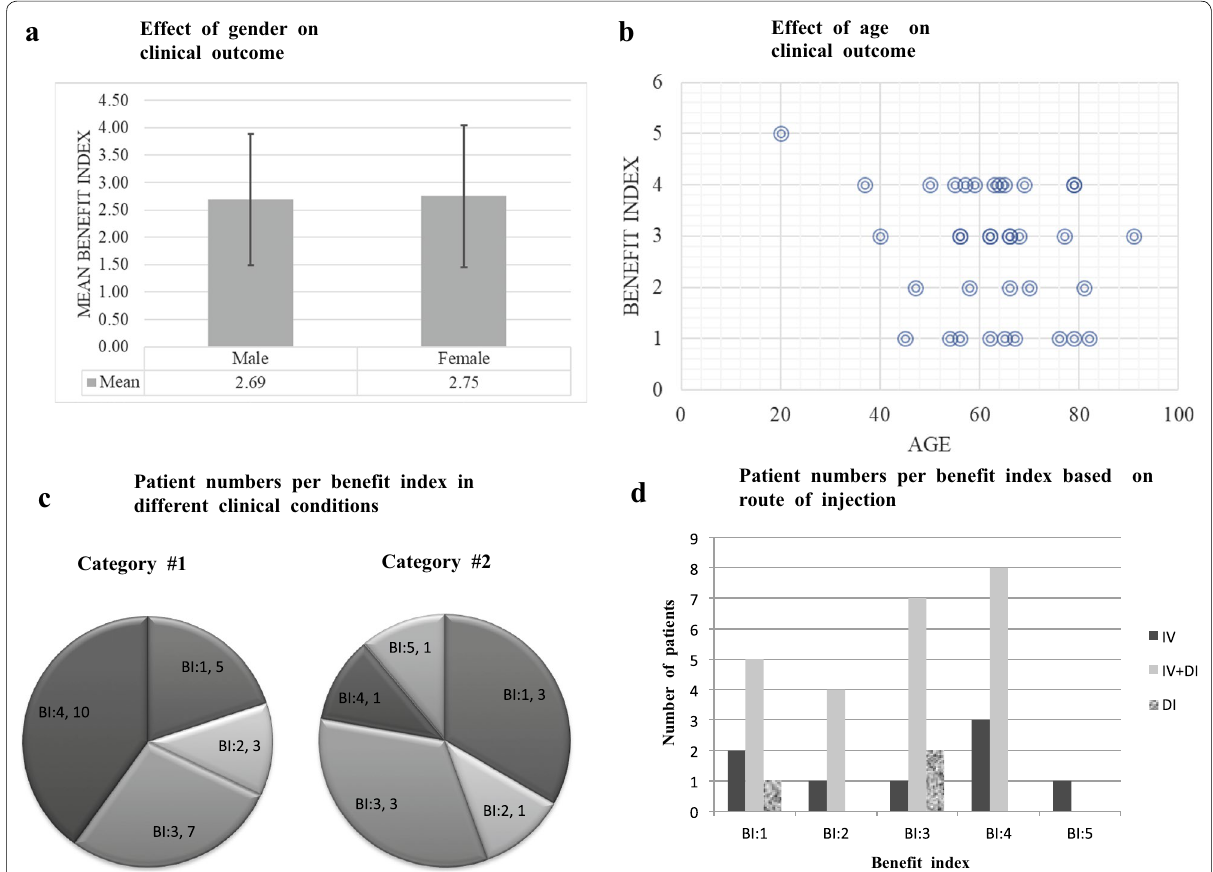
Fig. 1 Correlation between clinical outcome and gender ( a ), age ( b ), clinical conditions ( c ), different routes of injections ( d ). a The mean benefit index is shown as the height of the bars for males and females, with the error bars representing the 95% confidence interval. b A scatter plot of the age versus benefit index is shown. c The breakdown of distribution of the benefit index in various clinical conditions, where Category #1 represents orthopedic applications and Category #2 represents organ or tissue dysfunctions. d The number of SVF-treated patients with various routes of injec- tion is shown as the height of the bars, with the benefit index shown on the